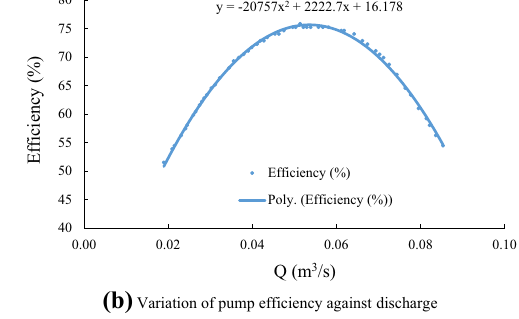
(b) Variation of pump efficiency against discharge Fig. 5 Pump and system characteristic